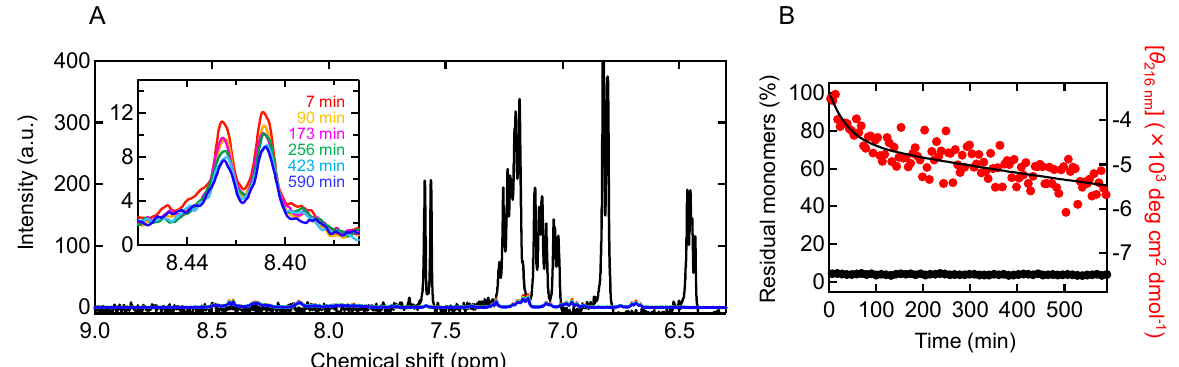
only allowed at low peptide concentrations. This reaction process is obviously different when compared to the reaction at pH 8.7, where aggregation and conformational changes occur synchronously [21].